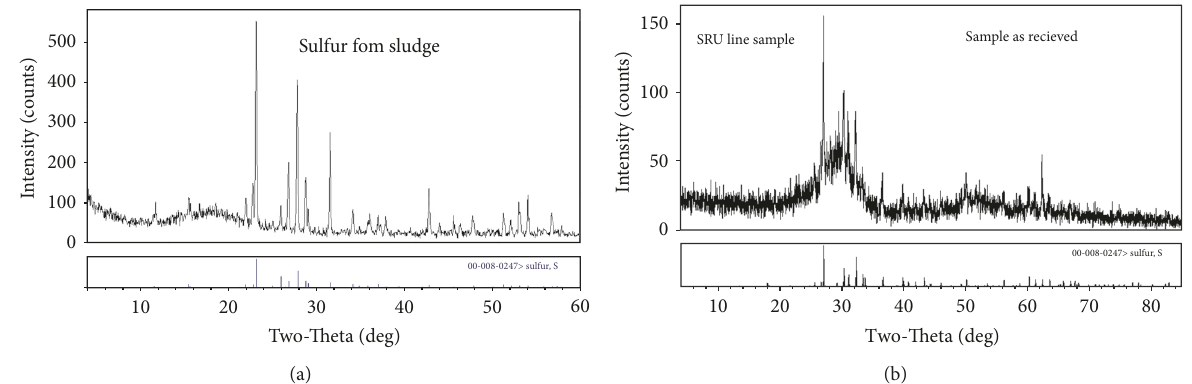
Figure 8: XRD phase identification results along with the standard reference minerals of the sulfur from the (a) sludge and (b) recovery unit line.